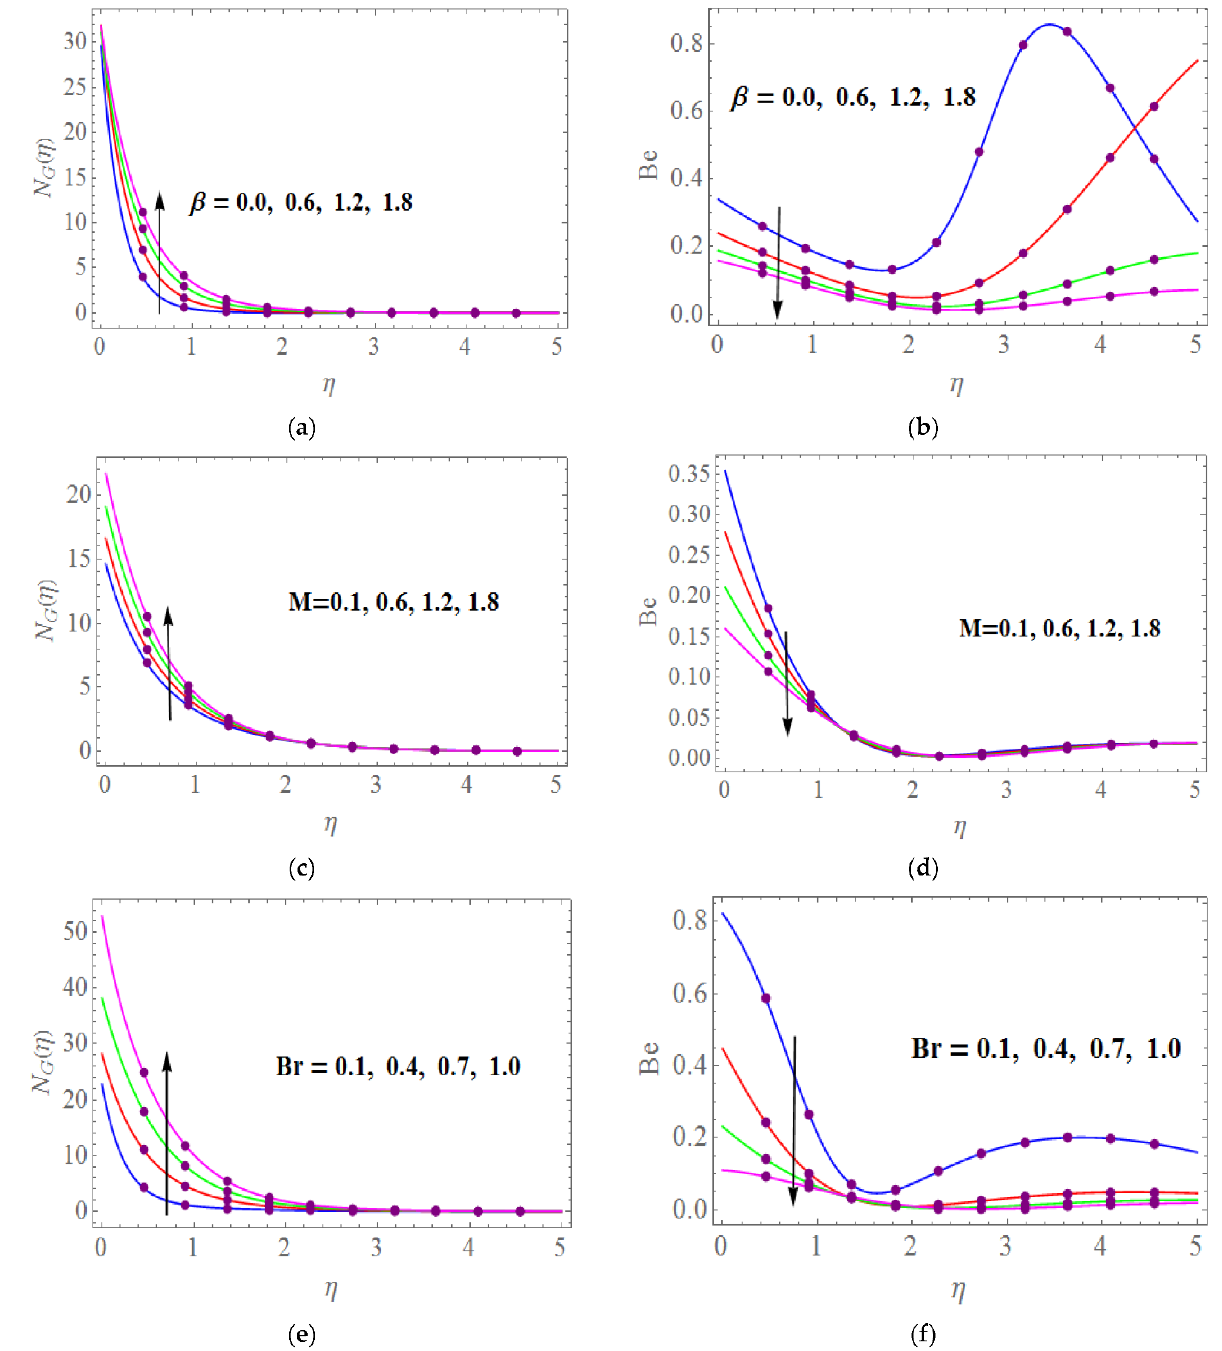
Figure 16. Entropy Generation and Bejan Number Analysis of MHD-SGFM. ( a ) Variation of β for N G ( η ) , ( b ) Variation of β for Be , ( c ) Variation of M for N G ( η ) , ( d ) Variation of M for Be , ( e ) Variation of Br for N G ( η ) , ( f ) Variation of Br for Be.